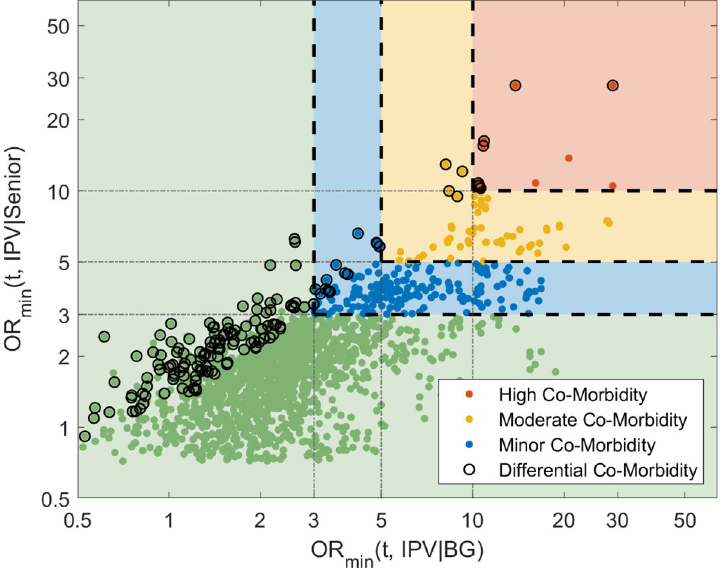
Fig 3. X-axis and Y-axis indicate the minimum bounds of 95% augmented confidence intervals (corrected to bound the FDR) for IPV co-morbidity scores in Senior and Background (BG) populations i.e., OR(t, IPV|Senior), and OR(t, IPV|BG) respectively. The terms identified with High/Moderate/Minor co-morbidity in both populations are shown in red/yellow/blue regions respectively. The terms identified as differentially co-morbid (having significantly higher co-morbidity in Senior population) are marked with black circles. OR: Odds ratio, IPV: Intimate partner